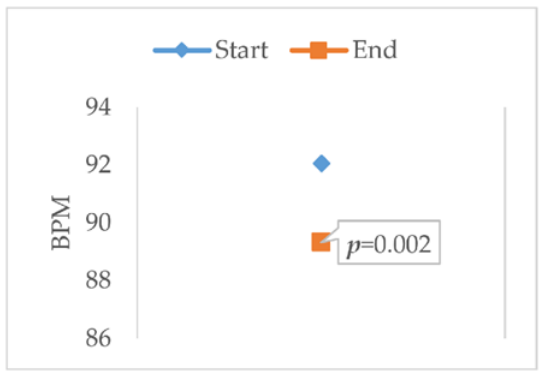
Figure 11. t-test: paired two sample for means of the pulse indicator (BPM: beats per minute).